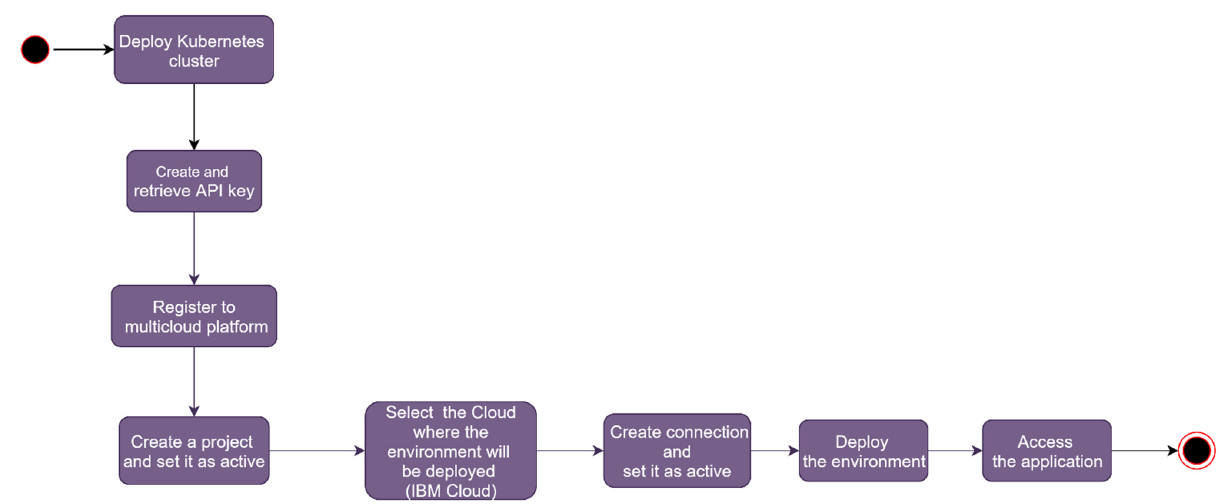
Figure 2. The automated deployment process for the IBM Cloud.